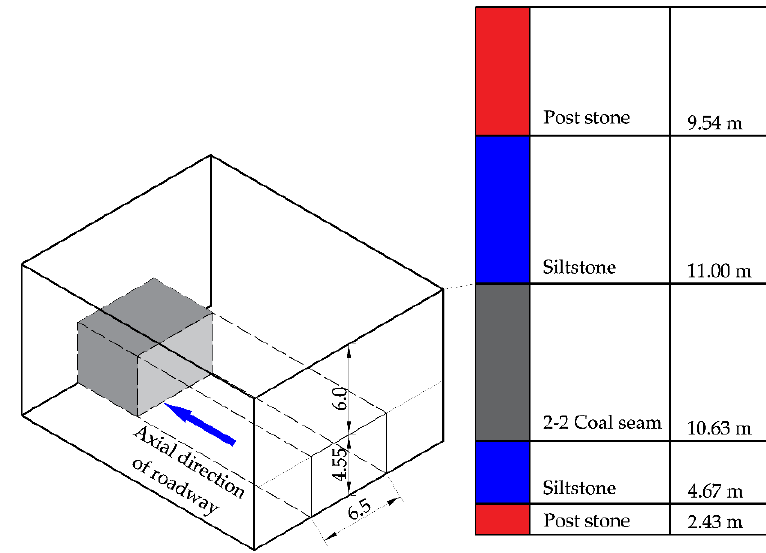
Figure 13. Geological survey of 122,110 auxiliary transport roadway.